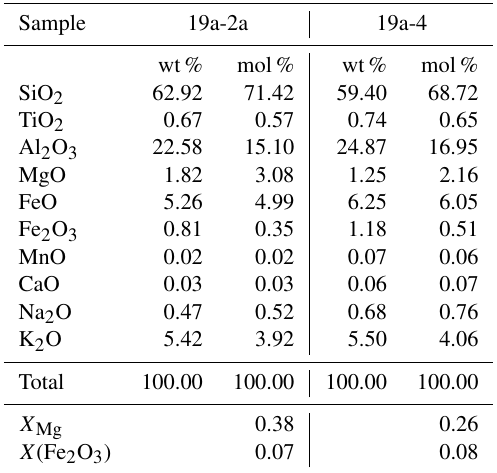
Table 1. Bulk compositions of the modelled samples.